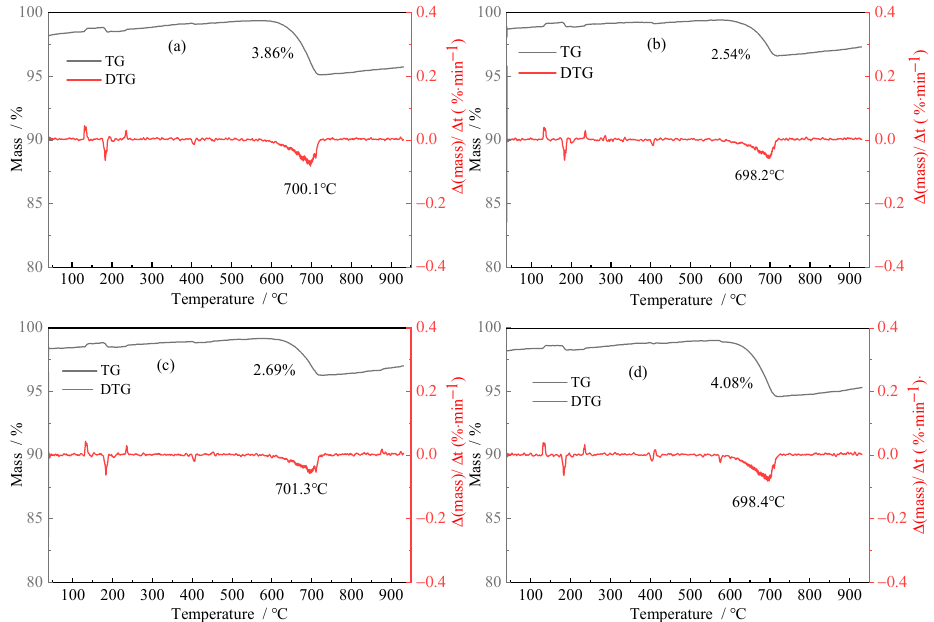
Figure 8. Anorthite fermentation solution carbonation product thermogravimetric curve: ( a ) Anor- thite + distilled water; ( b ) Anorthite + sterile medium; ( c ) Anorthite + bacteria; ( d ) Anorthite was cleaned after microbial leaching to remove the medium+ distilled water.